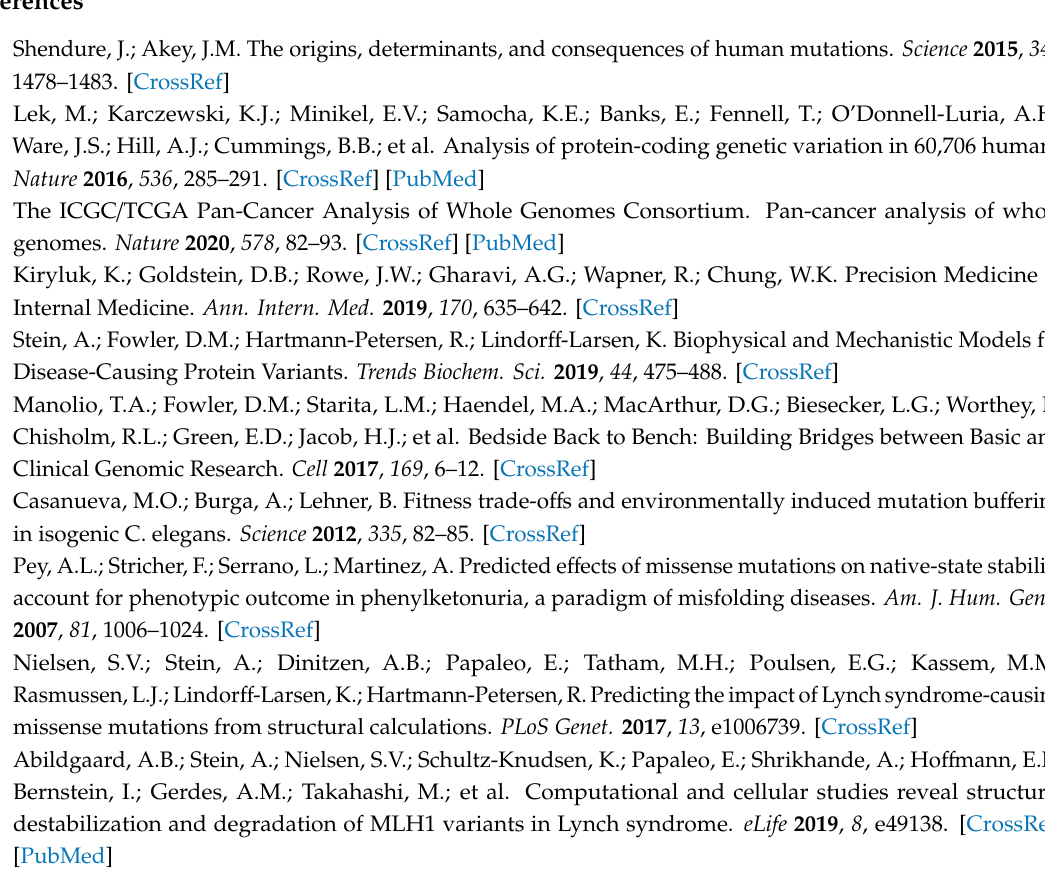
variants with Dic at 25 ◦ C. Figure S5. Thermodynamic dissection of Dic binding to NQO1 variants. Figure S6. HDX analysis of structural regions in which NQO1 mutations are localized. Table S1. E ff ect on conformational stability due to NQO1 mutations determined using structure-based methods. Table S2. Second-order rate constants ( k prot ) for proteolysis by thermolysin and mutational e ff ects on local stability ( ∆∆ G prot ). Table S3. FAD binding a ffi nity of NQO1 variants. Table S4. Thermodynamic parameters for Dic binding to NQO1 variants. Table S5. Magnitude of the conformational change (N conf ) associated with Dic binding from analysis of apparent binding enthalpies ( ∆ H) and heat capacities ( ∆ C p ). Table S6. Energetic dissection of mutational e ff ects as determined by Rosetta. Table S7. Analysis of steric clashes present in the NQO1 holo and NQO1 dic states caused by the mutation L7P. Table S8. Hydrophobic interactions established between V9 (WT) and I9 (mutant V9I) in the NQO1 holo and NQO1 dic states. Table S9. Regions with < 20% HDX after 3 h. Table S10. Regions with ∆ %D av ≥ 10%. Video S1. Morphing conformations between WT NQO1 dic and T16M mutated model. Video S2. Morphing conformations between WT NQO1 dic and WT NQO1 holo states. Video S3. Morphing conformations between WT NQO1 dic and Y20N mutated model. Video S4. Morphing conformations between WT NQO1 holo and Y20N mutated model. Video S5. Morphing conformations between WT NQO1 dic and A29T mutated model. Video S6. Morphing conformations between WT NQO1 holo and A29T mutated